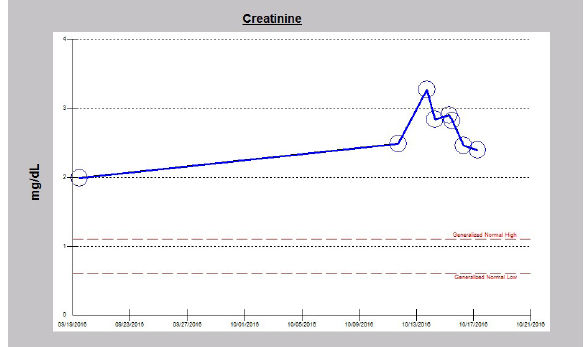
Figure 1. Acute kidney injury in October 2016 following unintentional misplacement of transurethral Foley catheter with inflated balloon in the distal right ureter.